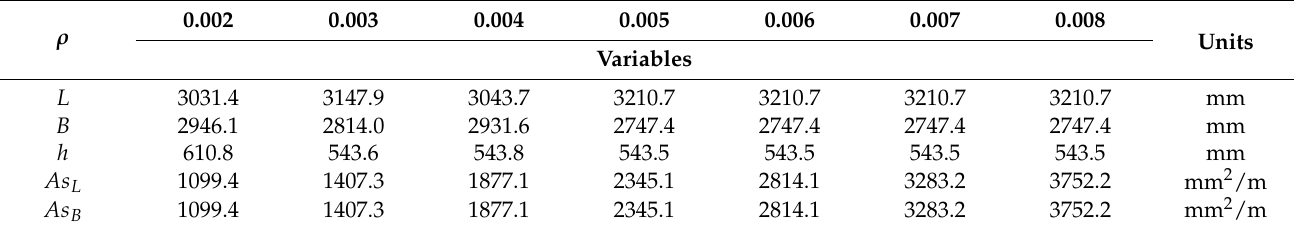
Table 9. Variables obtained for example 1 by varying steel ratio.